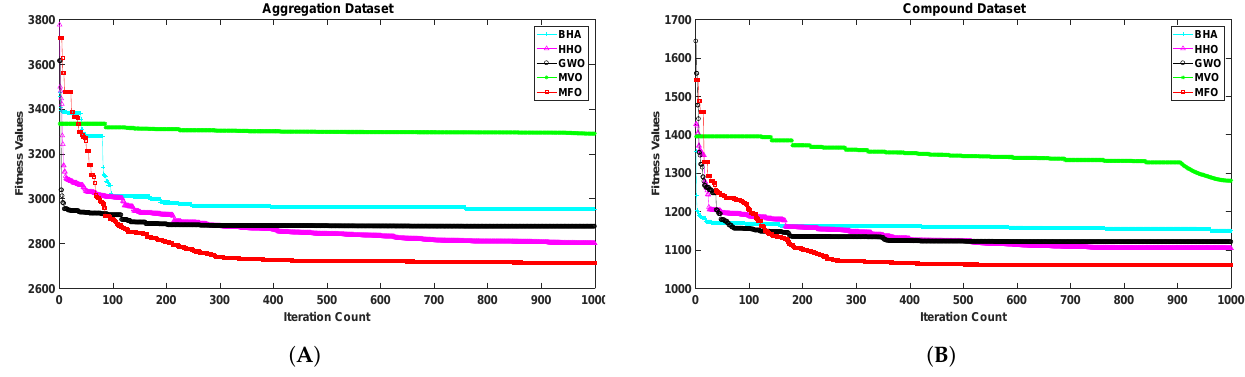
Figure 2. Variation in the best fitness values of algorithms for datasets ( A ): R15, ( B ): D31 with respect to iterations.